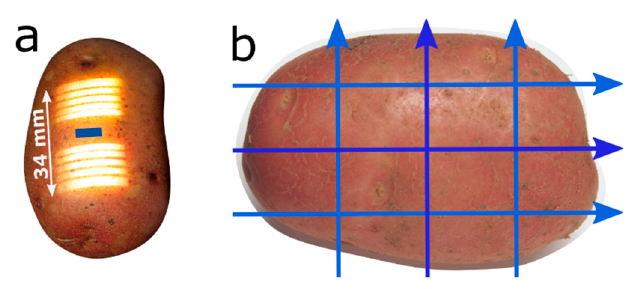
Figure 1. ( a ) Illustration of illumination pattern and the field of view of the system (blue rectangle). ( b ) Illustration of position of the FOV (field of view) during the scans during the robustness study. This pattern was used on two sides of each potato, center scans and off-center scans.